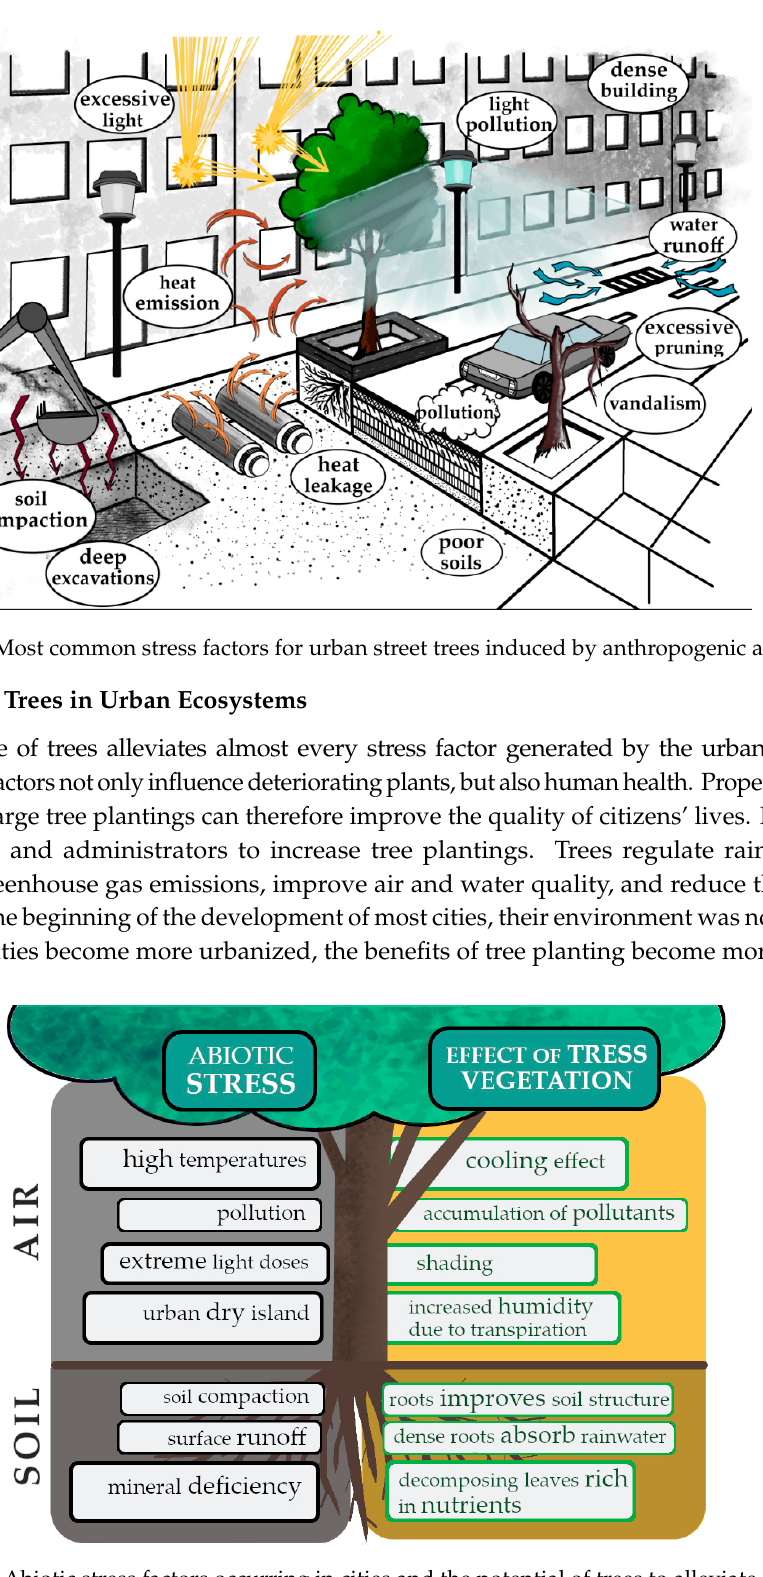
Figure 4. Abiotic stress factors occurring in cities and the potential of trees to alleviate them.